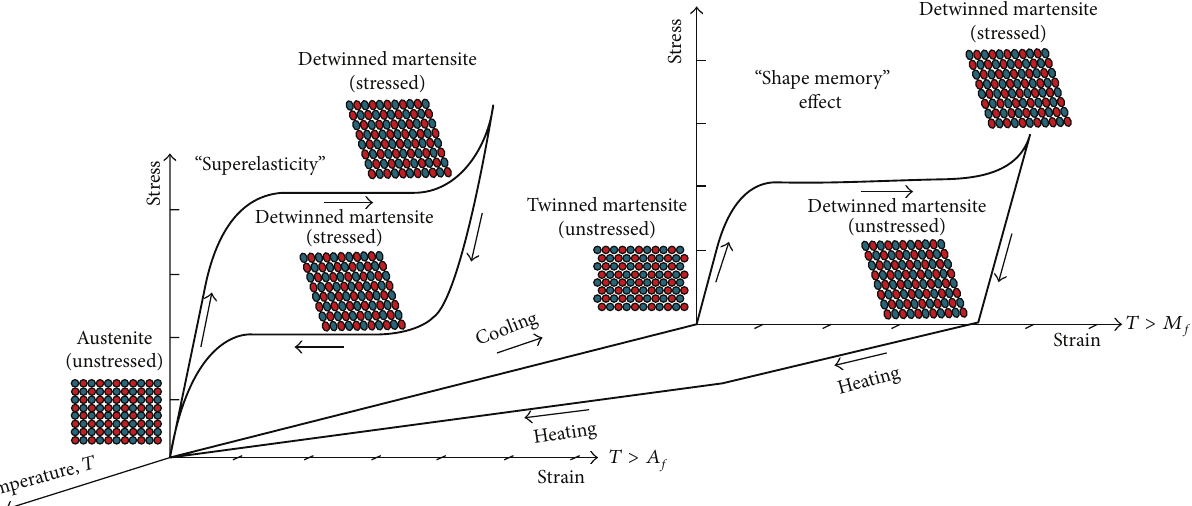
Figure 2: Stress and strain curves for shape memory alloy (SMA)